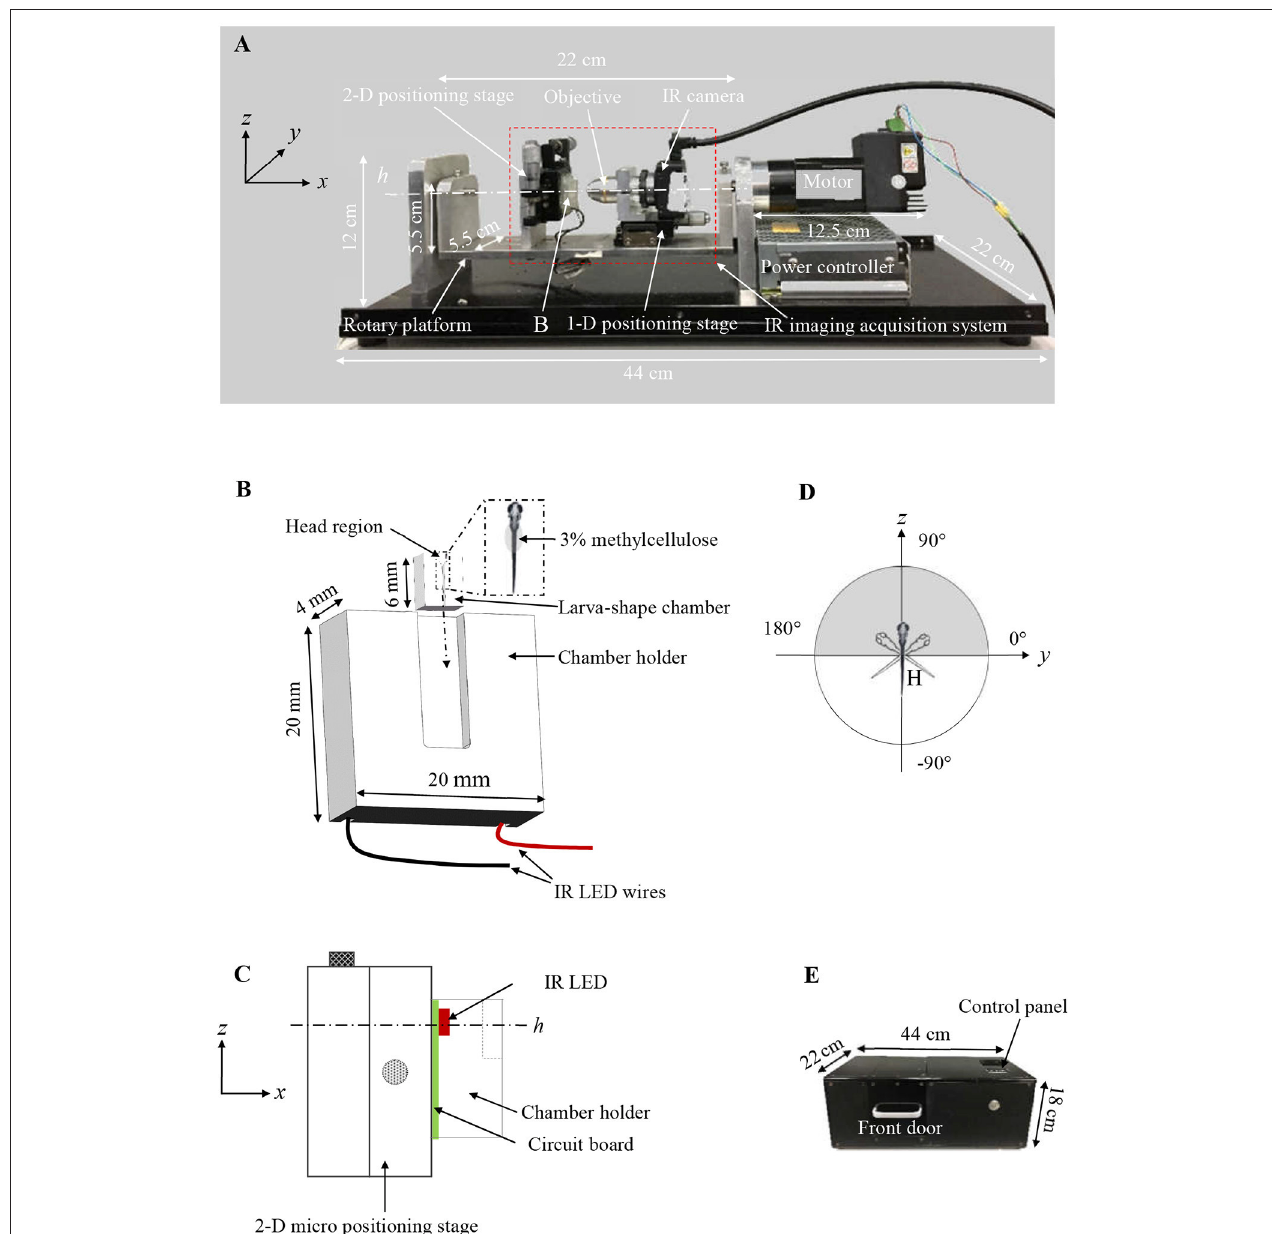
FIGURE 1 | (A) Customized VOR testing system. (B) A schematic drawing of the larva-shaped chamber and its holder. In the enlarged larva-shaped chamber (dashed rectangle), a larva is embedded in the chamber with 3% methylcellulose, dorsum is facing readers. After the larva-shaped chamber is inserted into its holder (following the dashed arrow), the chamber unit is in a position in which the larval head is up, perpendicular to the rotary platform swinging around the center ( h ) (C) , allowing the larva to rotate or “tick-tock” about the earth horizontal axis within its frontal plane (the gray area in D ). (C) A schematic drawing (in the yz plane) shows the assembly of the chamber holder (B) , IR LED (red) & circuit board (green), the 2-D positioning stage for the y & z direction. (D) A schematic diagram shows the rotatory trajectory of the larva (head) (gray) and the platform (white). (E) The black box to house the entire VOR acquisition system.